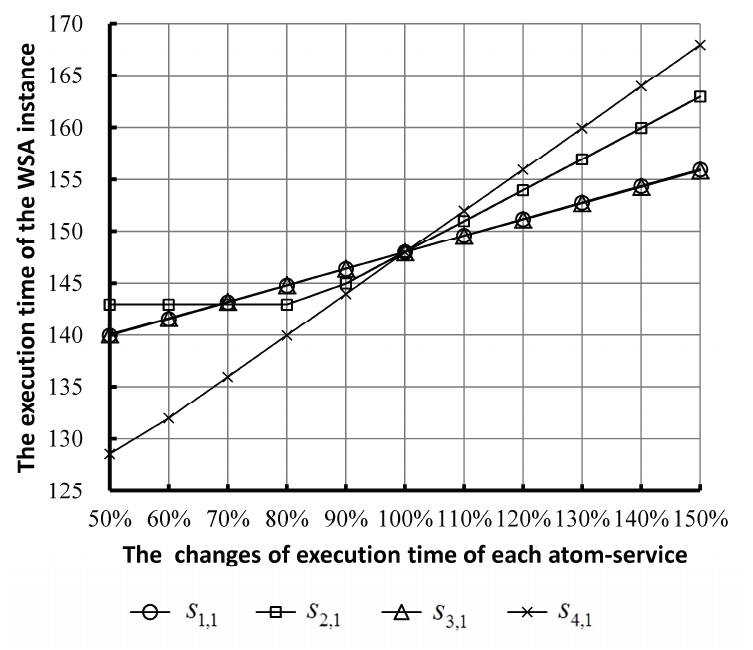
Figure 7. The influence on the execution time of the SCA instance by the changes of the execution time of each atom-service.